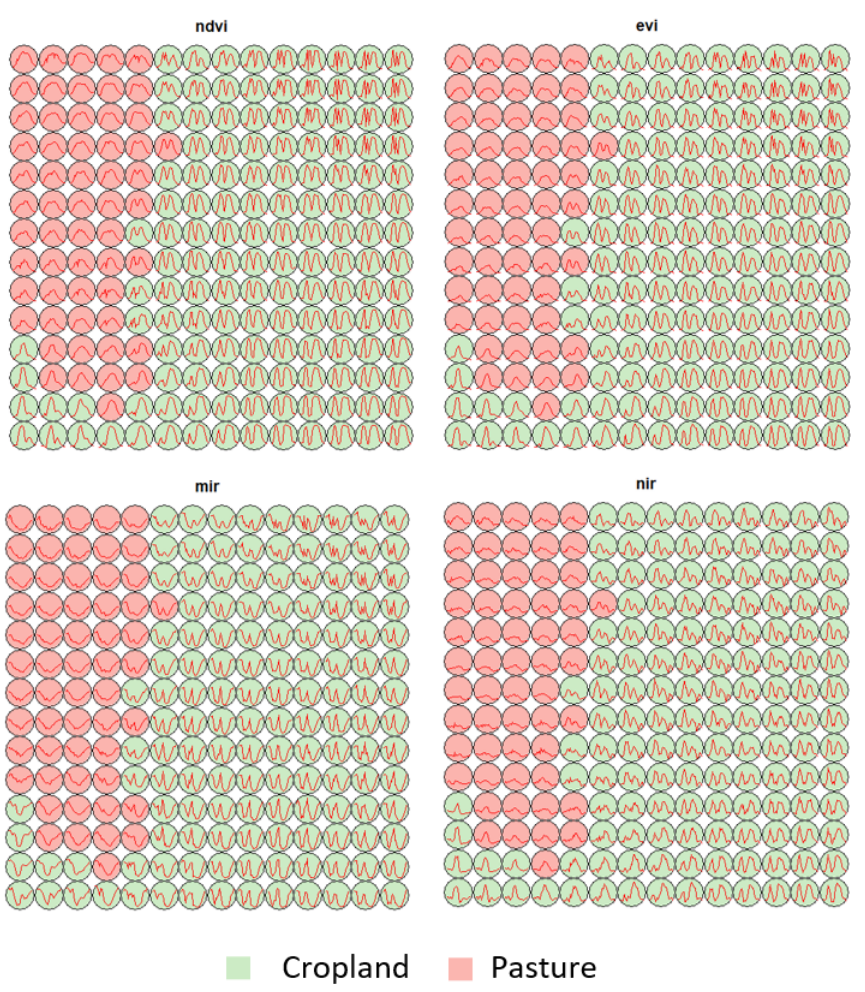
Figure 4. SOM grids. Each line inside the neurons is a weight vector generated by SOM to represent a set of sample in low-dimensional